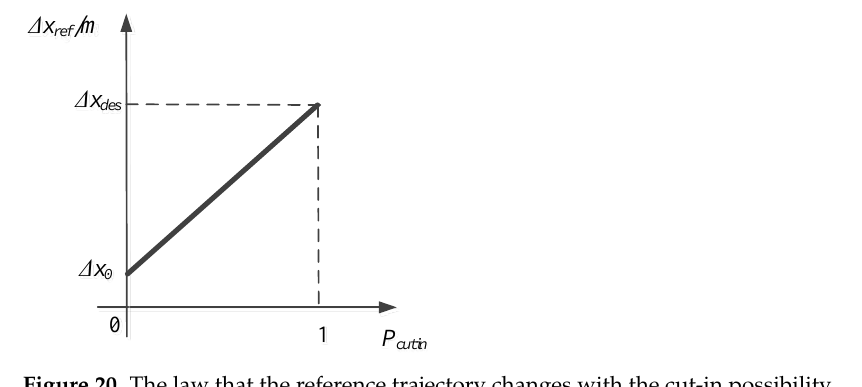
Figure 20. The law that the reference trajectory changes with the cut-in possibility.